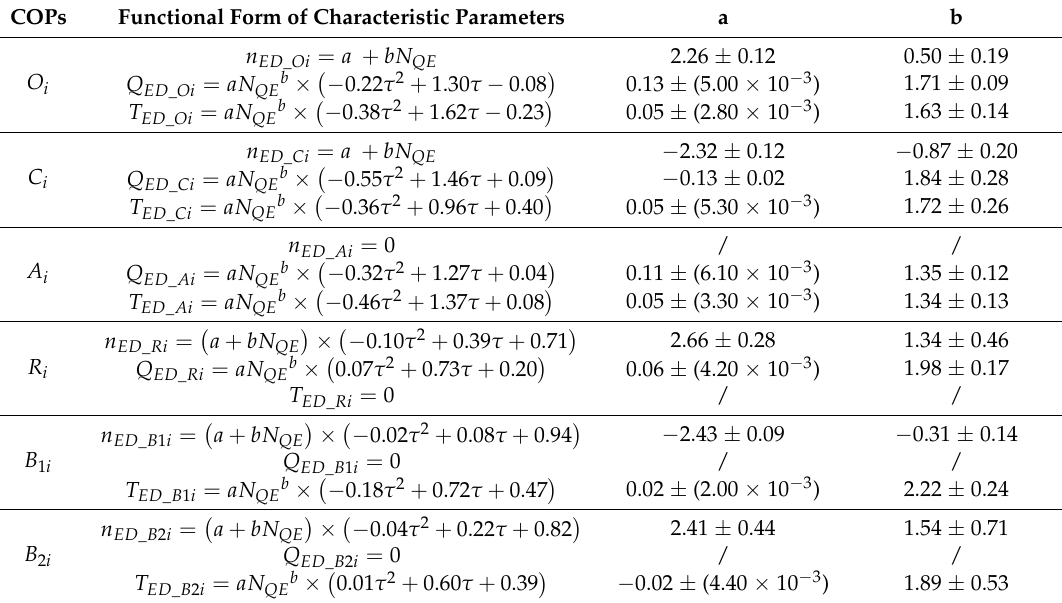
Table 2. Functional relation between the characteristic parameters of COPs and N QE , τ .